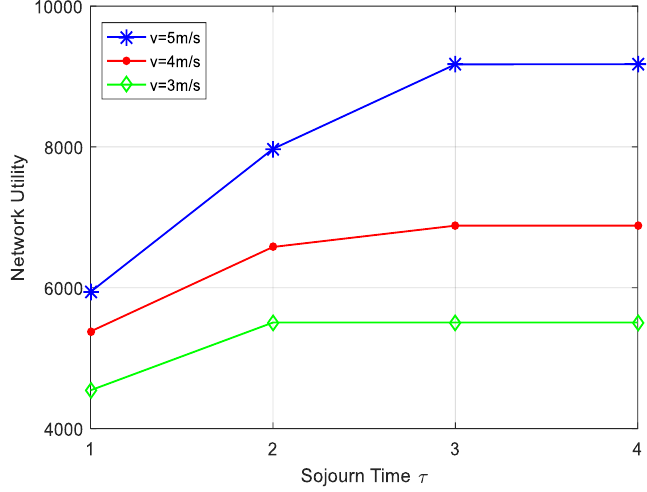
Figure 9. Impact of sojourn time and vehicle speed on network utility.